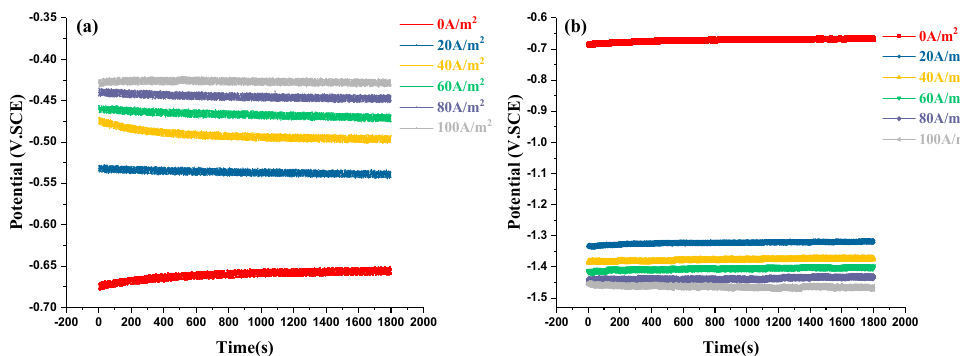
Figure 4. Potential measurements of the results of a 3PE-coated X80 steel sample under DC ( a ) anode and ( b ) cathode polarization.